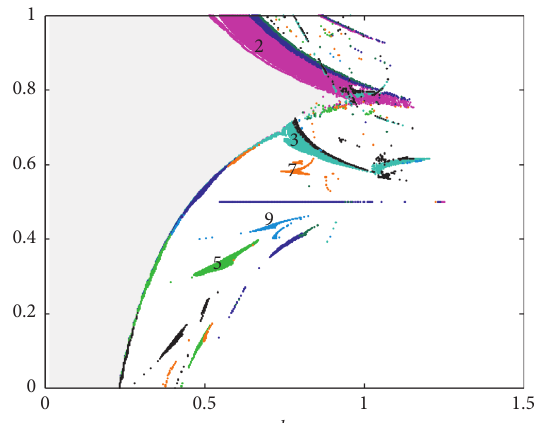
Figure 5: The 2D bifurcation diagram in the ( k, ω ) − plane. Different types of periodic cycles are numbered with different colors. The other parameters are a � 1 . 4 and c � 0 . 55.